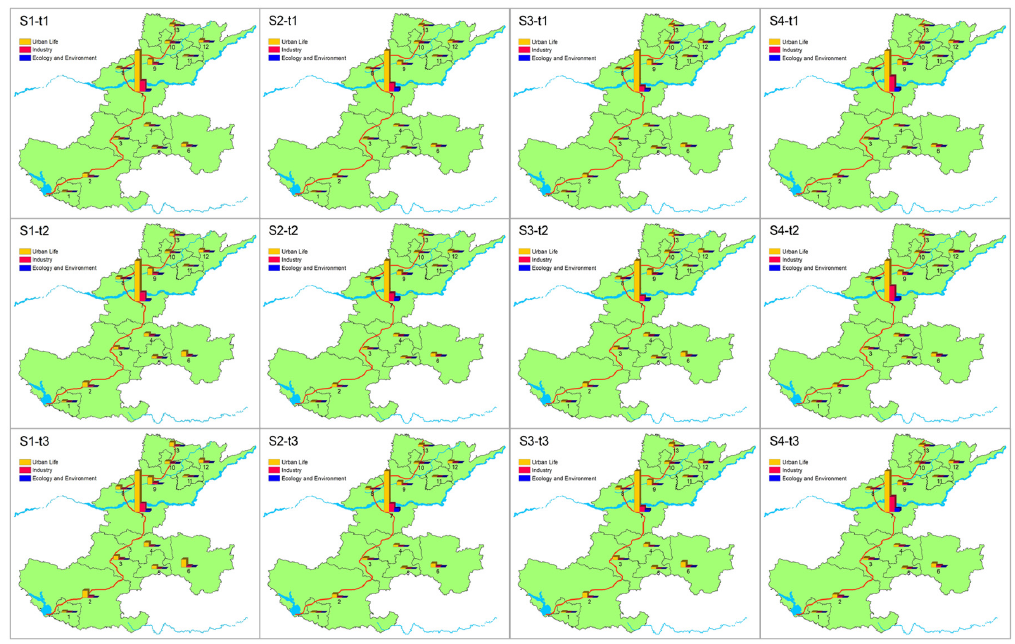
Figure 7. Amounts of COD emission under different scenarios in different departments and different. periods (10 3 tonnes). Note: S1, Scenario 1; S2, Scenario 2; S3, Scenario 3; S4, Scenario 4; t1, period 1; t2,period2; t3, period3; 1, Dengzhou City; 2, Nanyang City; 3, Pingdingshan City; 4, Xuchang City; 5,